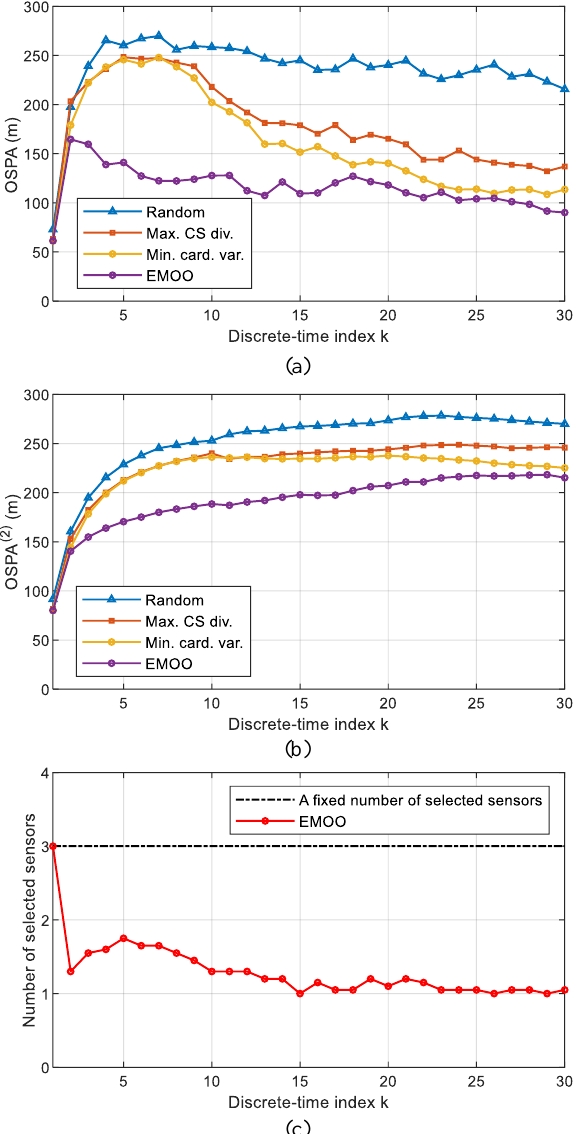
Figure 9. Average performance comparison in Scenario 1: ( a ) OSPA error; ( b ) OSPA ( 2 ) error; ( c ) the number of selected